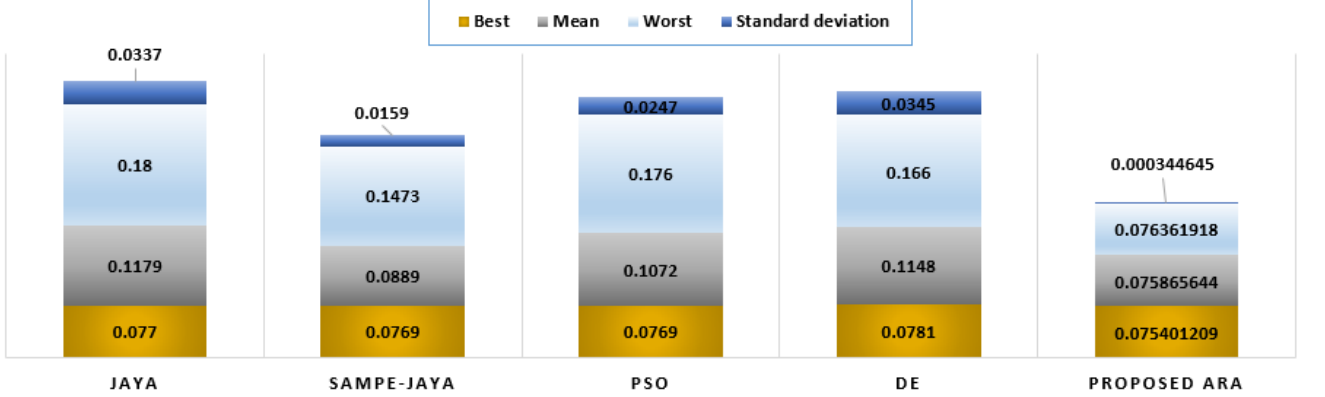
Figure 5. Statistical indices for SAMPE-JAYA, JAYA, DE, PSO and the proposed ARA under case study 1.